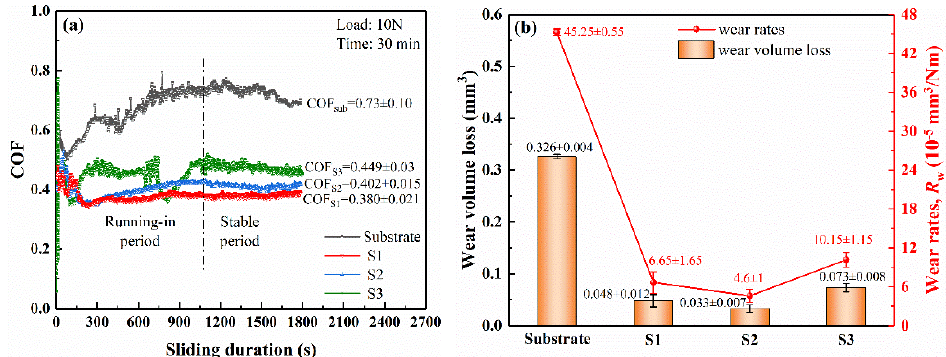
Figure 10. ( a ) Relationship between the COFs and sliding duration and ( b ) the wear volume loss and wear rates of three coatings taking the substrate as a comparison.